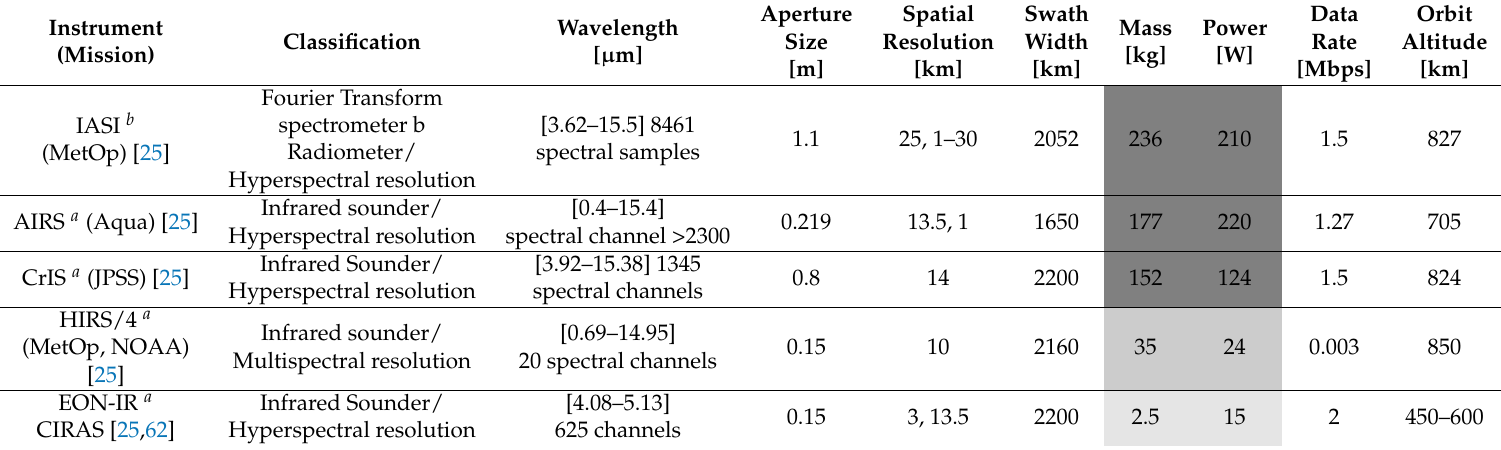
Table A9. Survey of optical sounders instruments: multispectral and